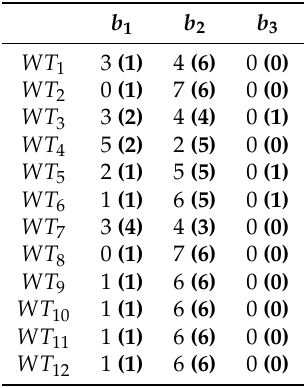
Table 6. Summary of vessel utilization based on WTs in Cases I–VII; deterministic